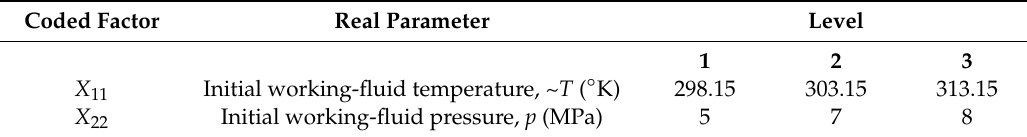
Table 7. Process parameters and their levels. Table 8. Research plan and results of the experiments; * Re > 2300 turbulent flow is considered. Experiment